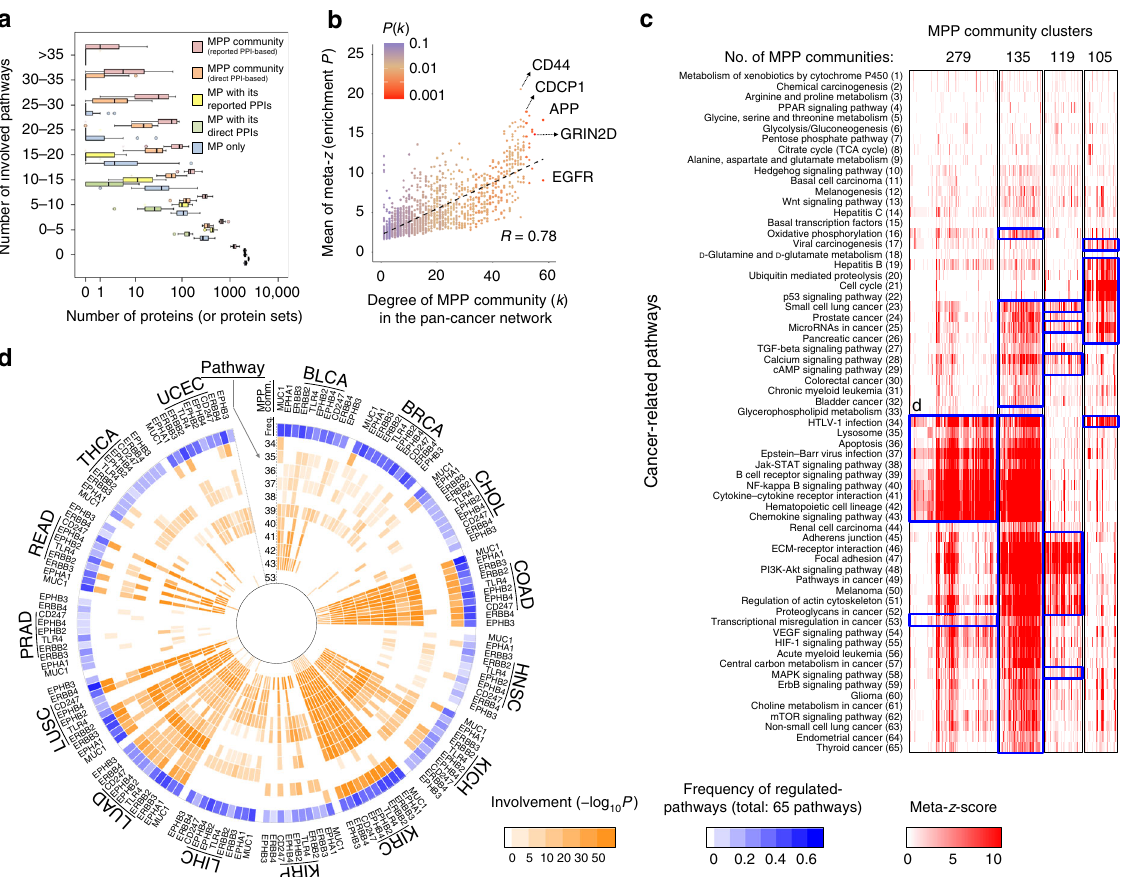
Fig. 3 Cancer-wide atlas of cancer membrane protein-regulated networks (CaMPNets). a Distributions (boxplot) between the numbers of involved pathways and proteins (or protein sets) in membrane protein (MP) itself, MP with reported/direct protein – protein interactions (PPIs), and MP with predicted PPIs and reported/direct PPIs (i.e., reported PPI- and direct PPI-based MPP (an MP with binding partners) communities) across 15 cancers when Pearson ’ s r of co-expressed gene pairs is set to r ≥ 0.5 or ≤ − 0.5. The box represents the interquartile range (IQR) and the line in the box is the median. The whiskers denote the lowest and highest values within 1.5 times IQR from the fi rst and third quartiles, respectively. Circles and asterisks represent the outliers and extreme outliers, respectively. b Scatter plot representation of the regulated pathway numbers (degree k ) and mean meta- z -scores of each MPP community in the pan-cancer network. The probability of the degree, P ( k ), of each MPP community ranges from low (red) to high (blue). c Heat map and hierarchical clustering of meta- z -scores for community-regulated pathways between MPP communities and 65 cancer-related pathways in 15 cancers. The four top clusters ranked by cluster size are shown, and details of the clusters for reported PPI-based and direct PPI-based community-regulated pathways are provided in Supplementary Data 3 and 4, respectively. The blue box shows the pathways regulated by most MPP communities ( ≥ 50%) in each cluster. d Involvements (orange) of the top 10 MPP communities with high frequencies of regulated pathways in the largest ( fi rst ranked; 279 communities) cluster across human cancers represented in polar histograms; three other clusters are shown in Supplementary Fig. 21. The MPP communities in each cluster are ranked by the frequencies of the regulated pathways (the most external circle) from high (blue) to low (light blue) and zero (white). The internal circles display strong (orange), weak (light orange), and no (white) involvement of community-regulated pathways in the CaMPNet. The number symbols refer to the pathways listed in c . Source data are provided as a Source Data fi